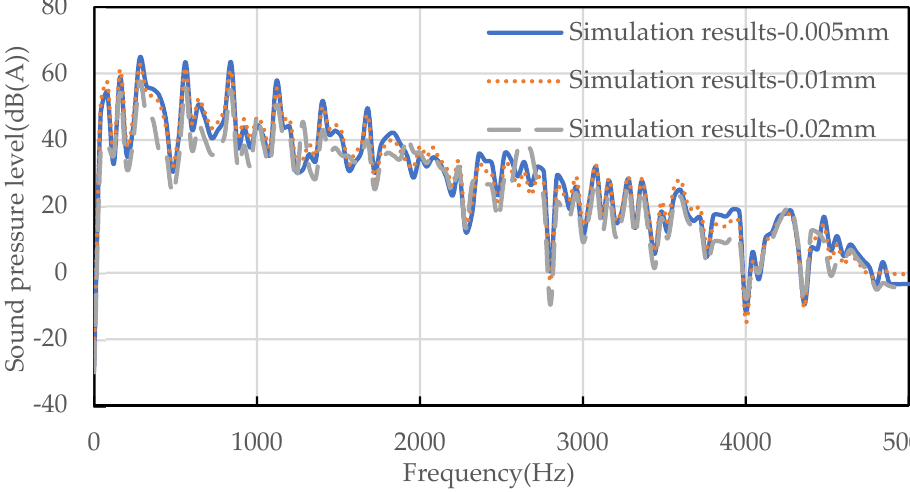
Figure 10. Sound sensitivity analysis of different mesh sizes. The total sound pressure levels corresponding to 0.005 mm, 0.01 mm, and 0.02 mm are 72.3 dB(A), 71.8 dB(A), and 69.7 dB(A), respectively. The results for the first boundary layer at 0.01 mm and 0.005 mm are very close in terms of the total sound pressure level.